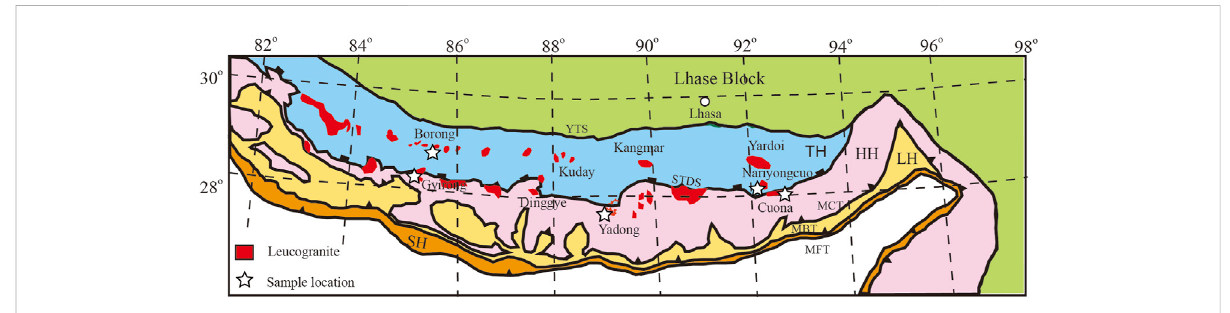
FIGURE 1 A simpli fi ed geologic map of the Himalayan orogenic belt. TH, Tethyan Himalaya; HH, High Himalaya; LH, Lesser Himalaya; SH, Sub-Himalaya; YZS, Yarlung Zangbo Suture Zone; STDS, Southern Tibetan Detachment System; MCT, Main Central Thrust; MBT, Main Boundary Thrust; MFT, Main Frontal Thrust.